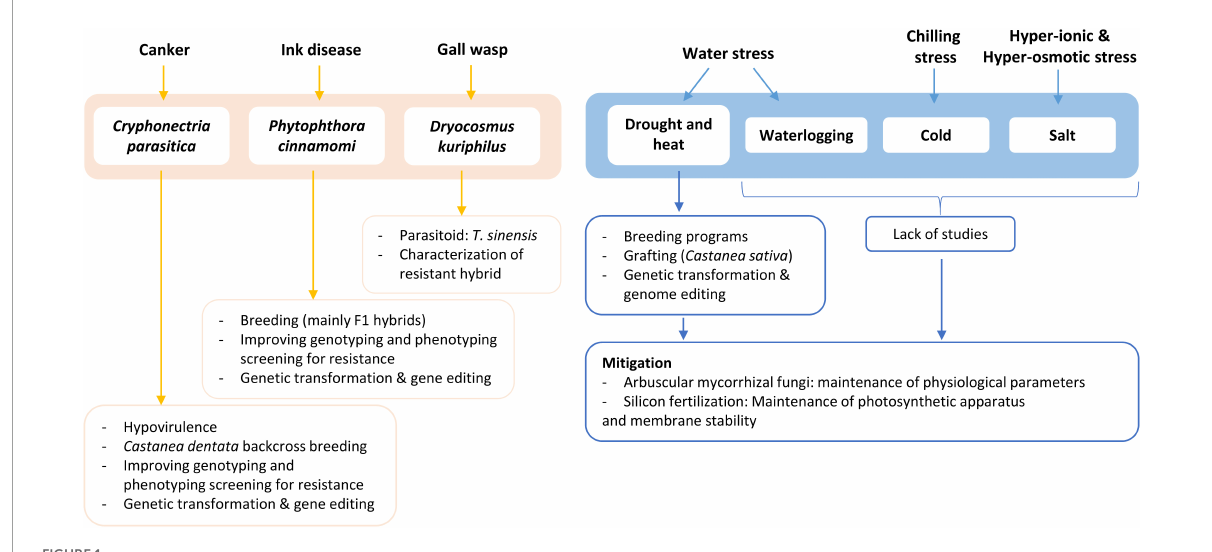
FIGURE1 Schematic overview of the main topics discussed in this review. Information includes disease/stress, causal agent, and efforts for control/mitigation, in process or in